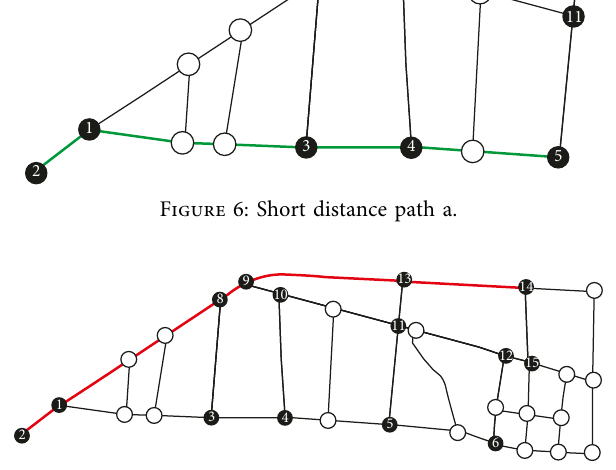
Figure 7: Medium distance path b.